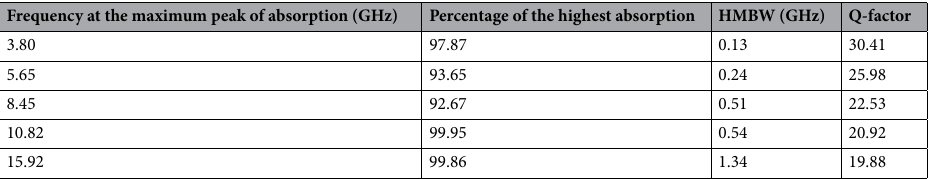
Table 3. MAA unit cell’s Q factor and bandwidth for various application bands.